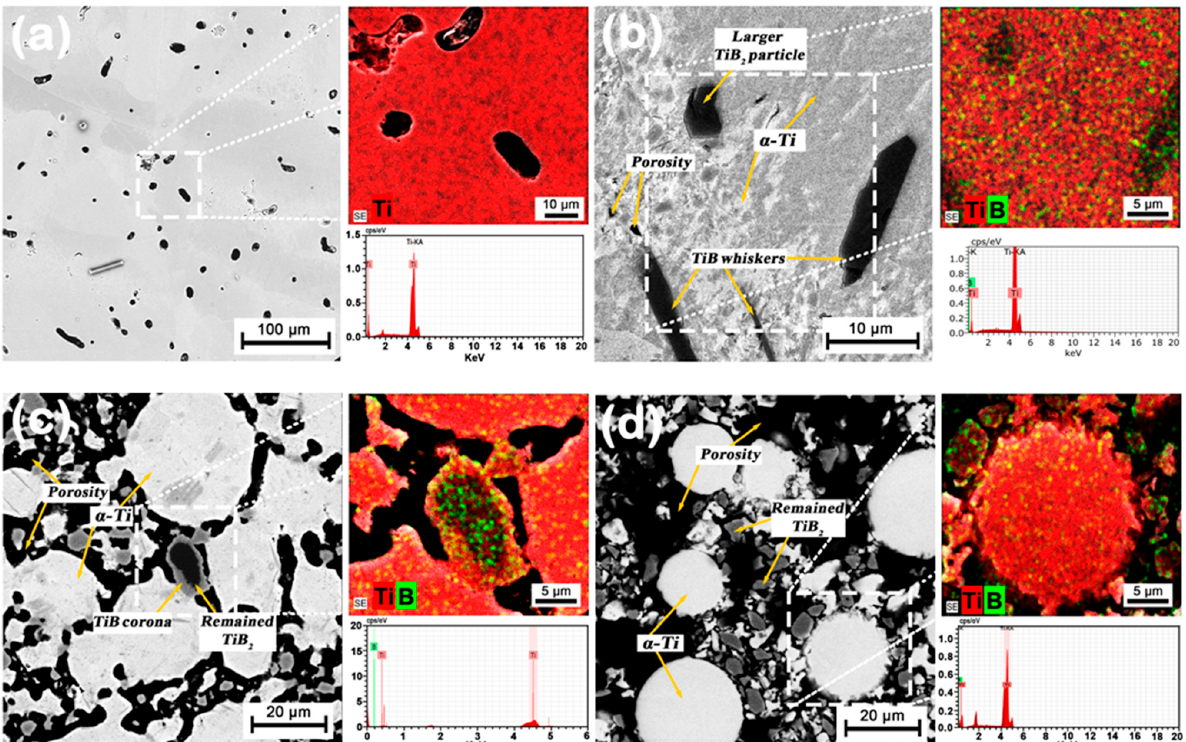
Figure 5. EDS analysis results for ( a ) U-c, ( b ) R3-c, ( c ) R10-c, and ( d ) R30-c samples.